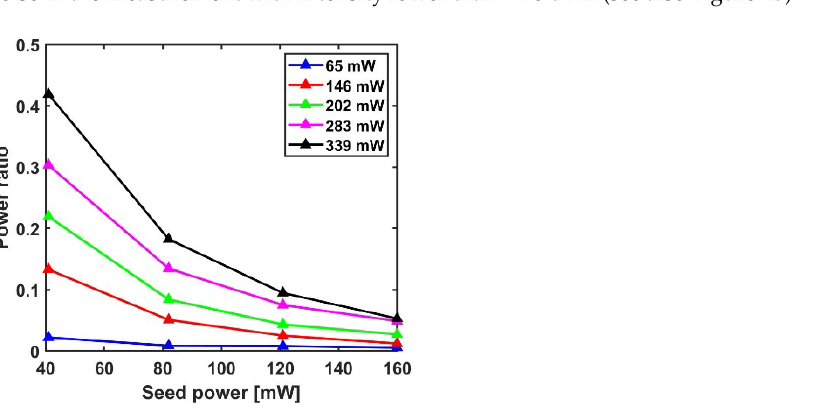
Figure 4. The variation of spectra with seed power. Pump power: ( a ) 146 mW; ( b ) 202 mW; ( c ) 283 mW; ( d ) 339 mW. The noise in these figures is induced by the unavoidable background noise in the measurement with intensity lower than − 70 dBm (see also Figure 2b).